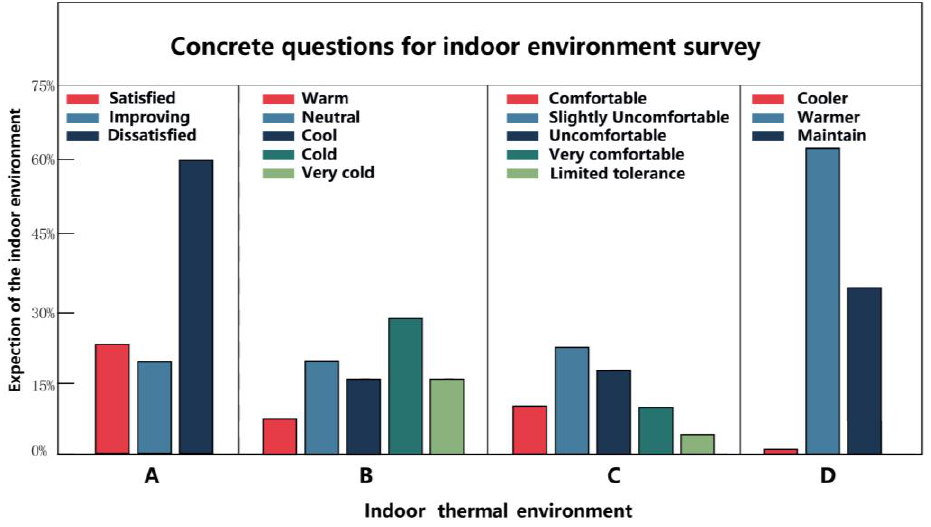
Figure 2. Concrete questions for indoor environment survey.